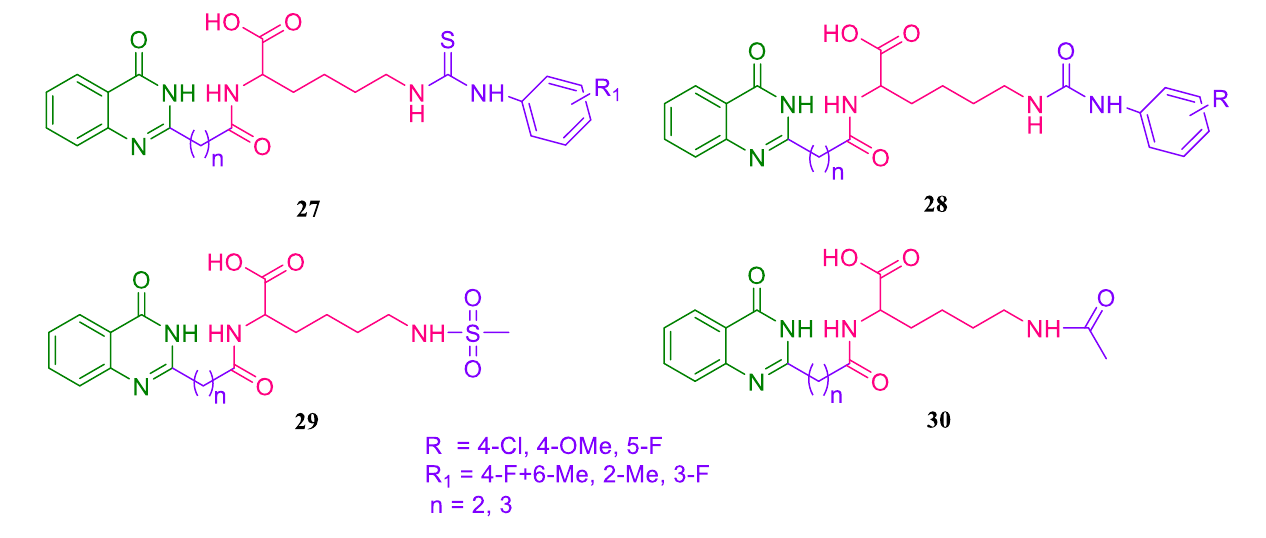
Figure 33. Lys-quinazolinone conjugates.